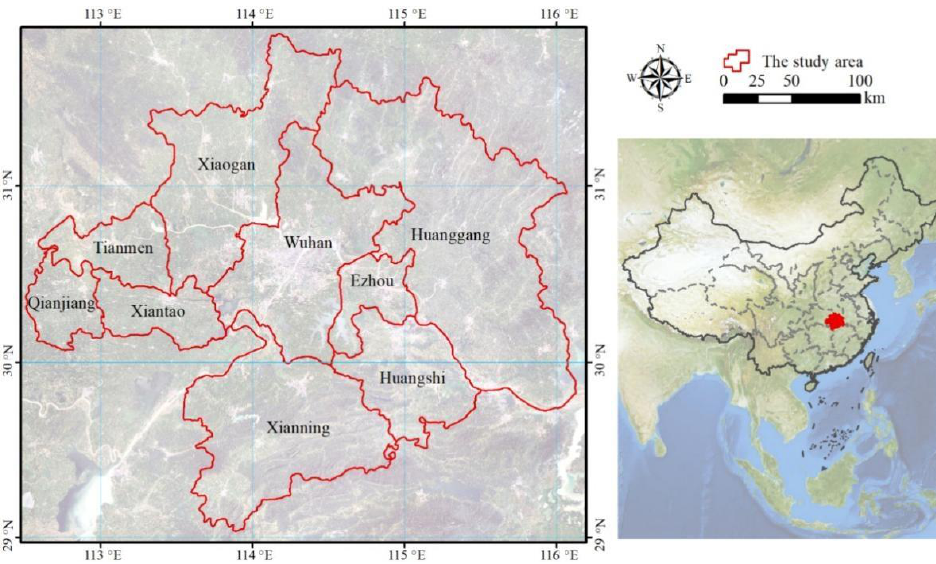
Figure 1. Location of the Wuhan City Circle area in China.